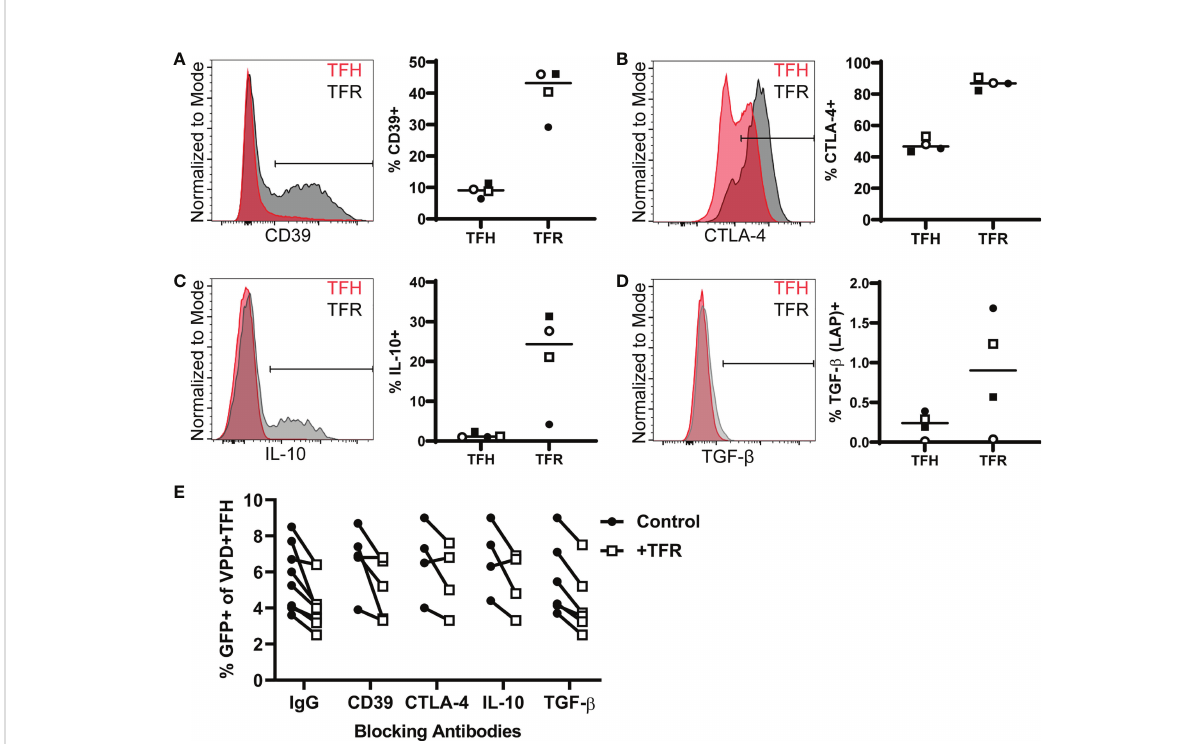
FIGURE 2 TFR mediated reduction of HIV replication is independent of CD39, CTLA-4, IL-10, or TGF- b . (A) CD39 surface expression in TFH and TFR from freshly isolated tonsil CD4 + T cells is shown in a representative histogram overlay (left) and TFH and TFR percentages expressing CD39 from four tonsils (right). (B) CTLA-4 expression in TFH and TFR from freshly isolated tonsil CD4 + T cells is shown in a representative histogram overlay (left) and percentages of TFH and TFR expressing CTLA-4 plotted from four tonsils (right). (C-D) Tonsil CD4 + T cells were stimulated with PMA/ Ionomycin for 5 hours in the presence of Monesin. Cells were fi xed, permeabilized, and stained for IL-10 (C) or TGF- b (D) as shown by a representative histogram (left) and percentages of IL-10 + (C) or TGF- b + cells (D) in TFH and TFR from four tonsils (right). (E) TFH were spinoculated with CXCR4-tropic HIV GFP reporter virus, labeled with VPD, and cultured for fi ve days at a ratio of 1:1 with uninfected, unlabeled TFH (control) or TFR in media supplemented with 10 IU/ml IL-2 and 5 m M saquinavir in the presence or absence of blocking antibodies to CD39, CTLA-4, IL-10, or TGF- b . GFP expression was measured after 5 days by fl ow cytometry according to the gating strategy in Figure